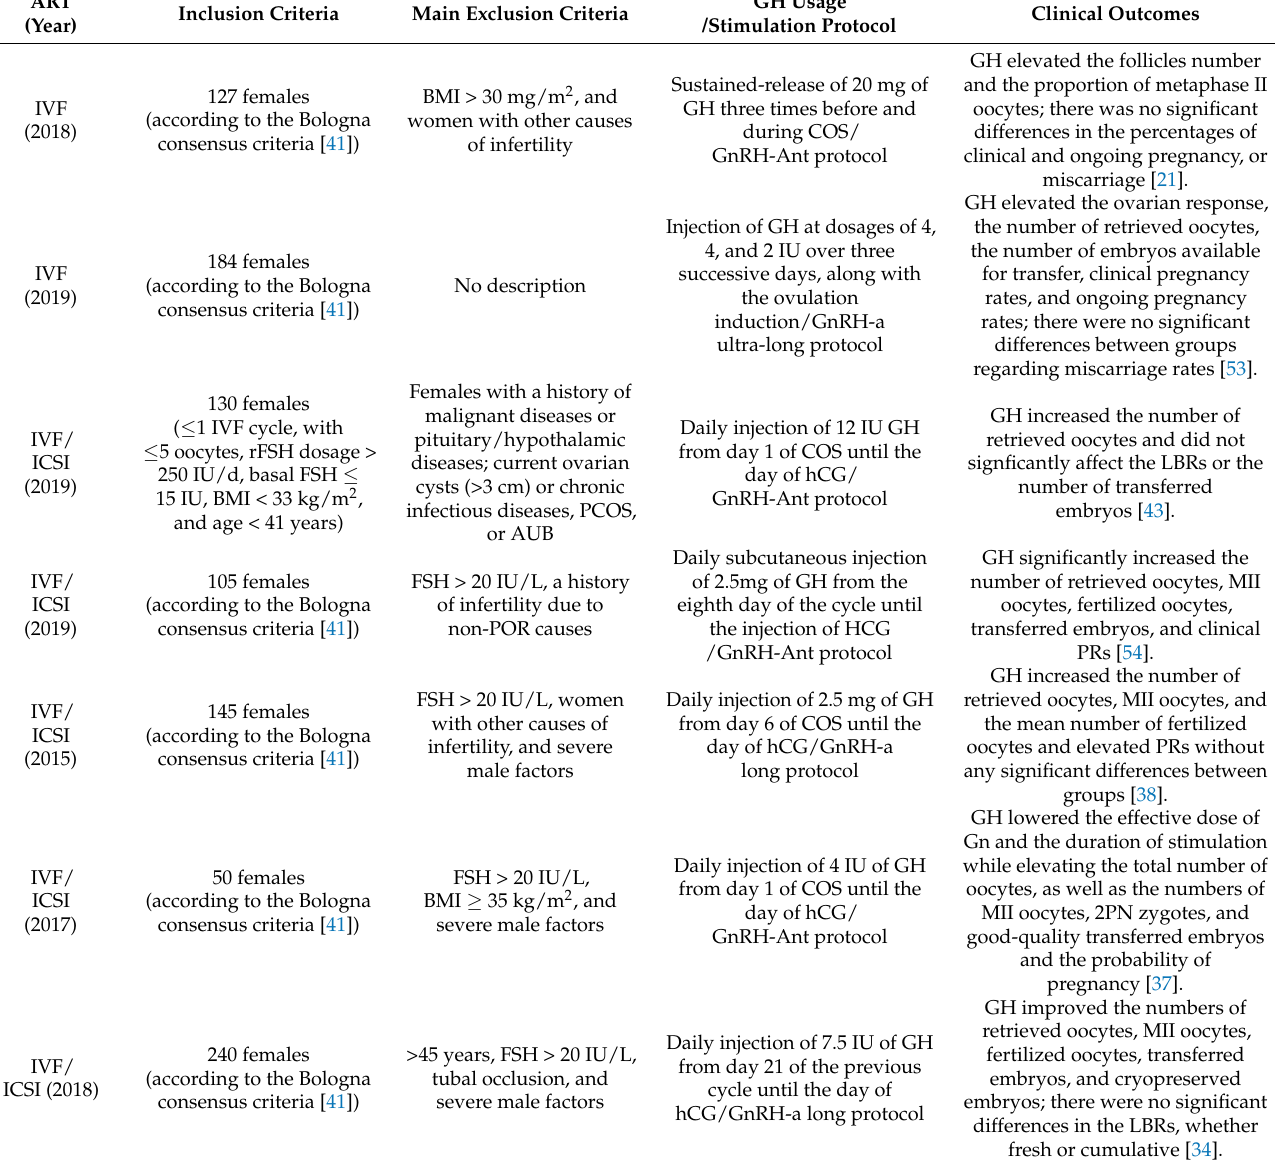
Table 1. The randomized controlled studies on growth hormone cotreatment in poor ovarian